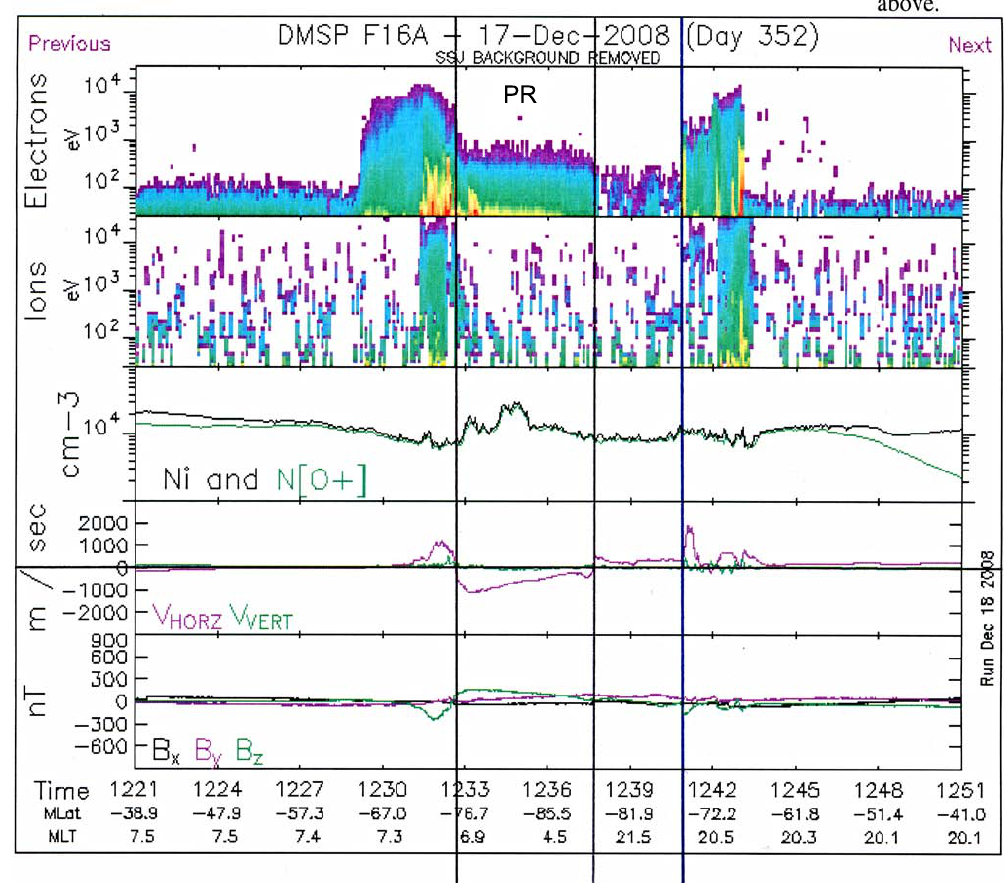
Fig. 4. DMSP F16 Southern Hemisphere data for the interval 12:21–12:51UT on 17 December 2008. Panels from top to bottom show electron precipitation flux, ion precipitation flux, ion densities, cross track ion drifts, and magnetic deflection components B x , B y , and B z . Polar rain (PR), polar arcs (PA) and dropout of polar rain on the dusk side of the arcs have been marked. Different convection/precipitation states are marked by vertical guidelines. Dropout of polar rain in the regime of sunward convection is marked by the second and third vertical